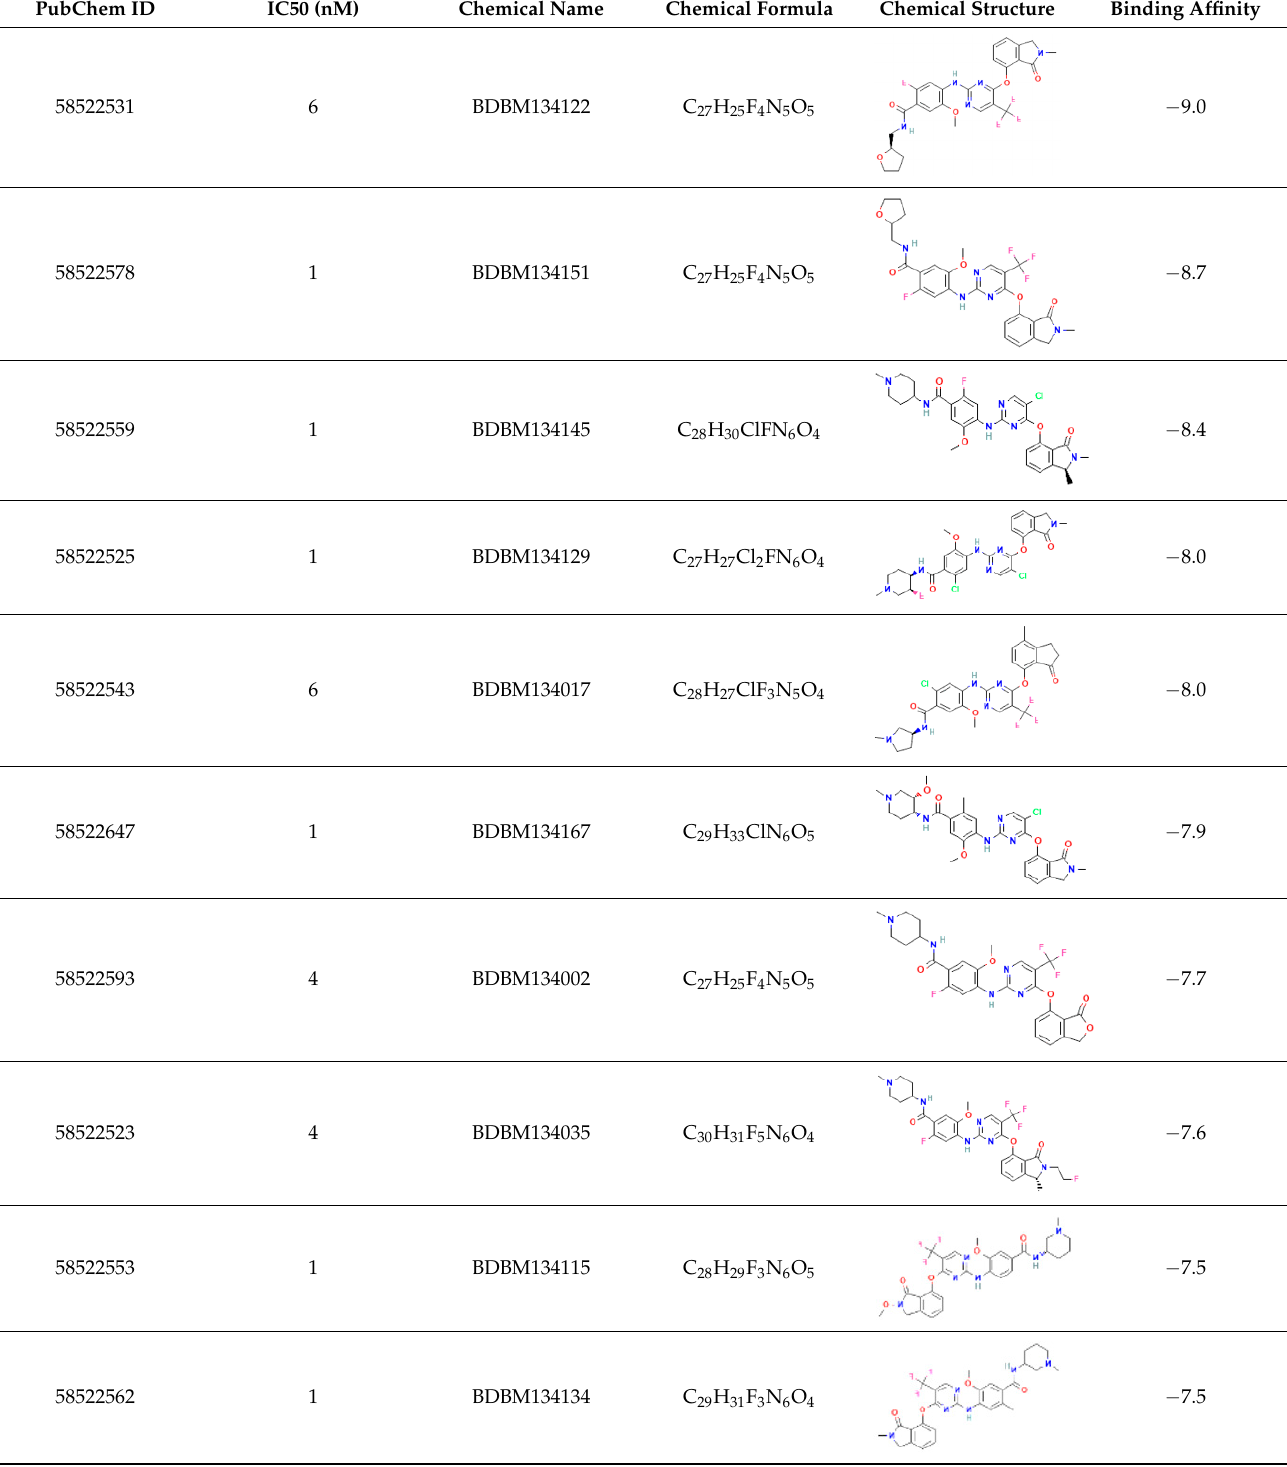
Table 1. List of 10 known active antagonists of FAK1 protein and their binding affinity toward the protein generated through molecular docking